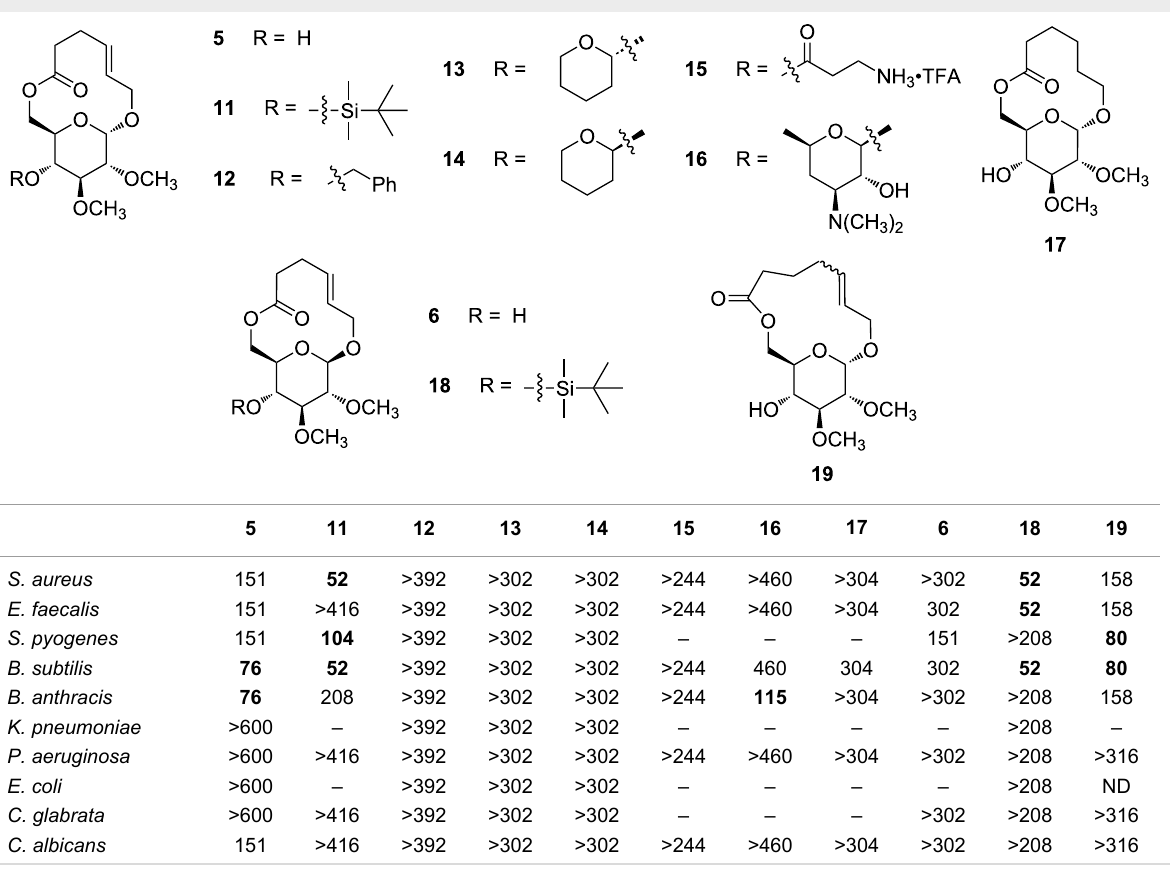
Table 2: MIC ( μ g/mL) values for compounds 5 , 6 and 11 – 19